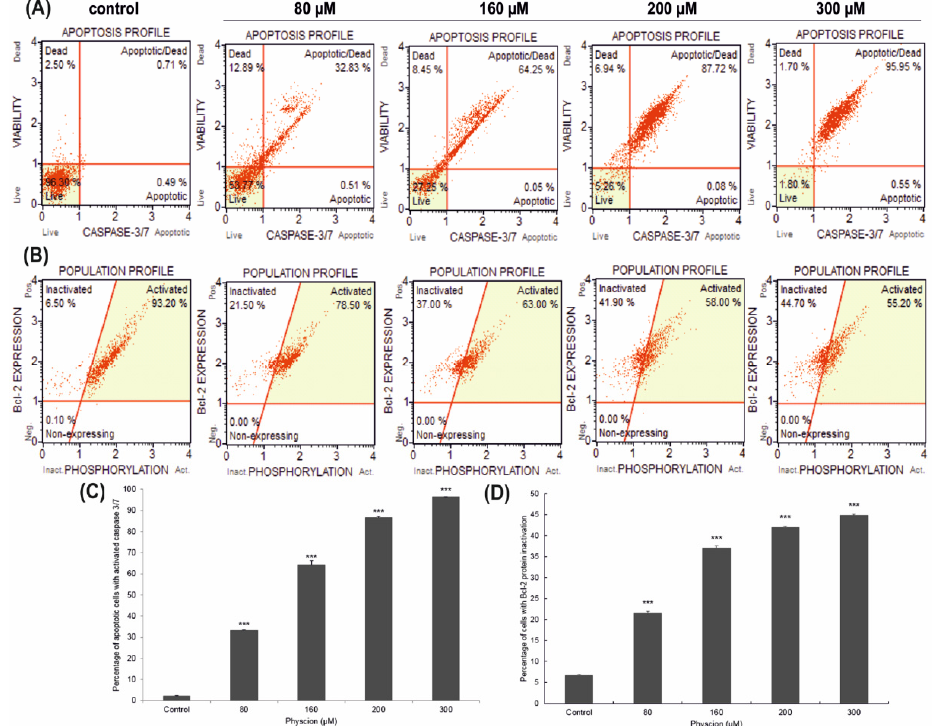
Figure 2. Effect of physcion on caspase 3/7 activity and Bcl-2 levels. Cells were treated for 48 h with physcion at concentrations of 80 µ M, 160 µ M, 200 µ M and 300 µ M ( A ). Live cells (caspase 3/7-/7-AAD-), early apoptotic cells (caspase 3/7+/7-AAD-), late apoptotic (caspase 3/7+/7-AAD+), dead cells (caspase 3/7-/7-AAD+) ( B ). Bcl-2 expression profile in physcion-treated HeLa cells. Cells expressing Bcl-2 are clustered in the top two quadrants of the scatterplot (inactive and activated). As a result of the action of physcion in increasing concentrations, an increased number of cells with inactivation of the Bcl-2 protein was observed. At a concentration of 300 µ M, more than 44% were dephosphorylated, which confirms the inactivation of the Bcl-2 signaling pathway. Concentration-dependent percentage of cells with Bcl-2 protein inactivation ( C ) and apoptotic cells with activated caspase 3/7 ( D ). Data representative of three parallel experiments correspond to mean values ± standard error. The differences were statistically confirmed at: *** p <